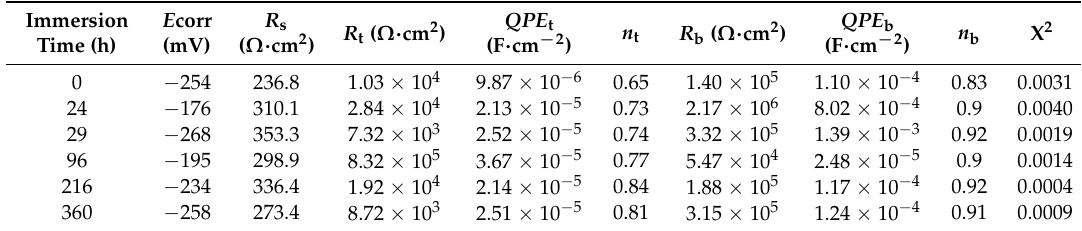
Figure 13. Equivalent circuit used to model EIS data of the NT sample. Table 8. Values of circuit equivalent elements of NT